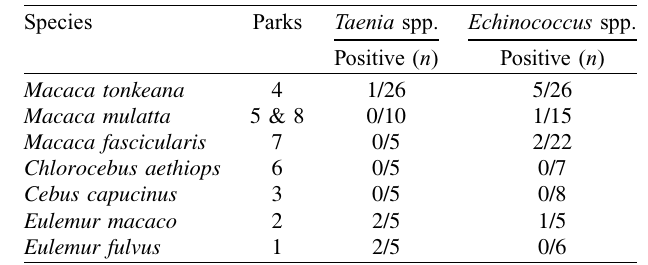
Table 1. Non Human Primate seroprevalences for Taenia spp. and Echinococcus spp. according to sex. Taenia spp.